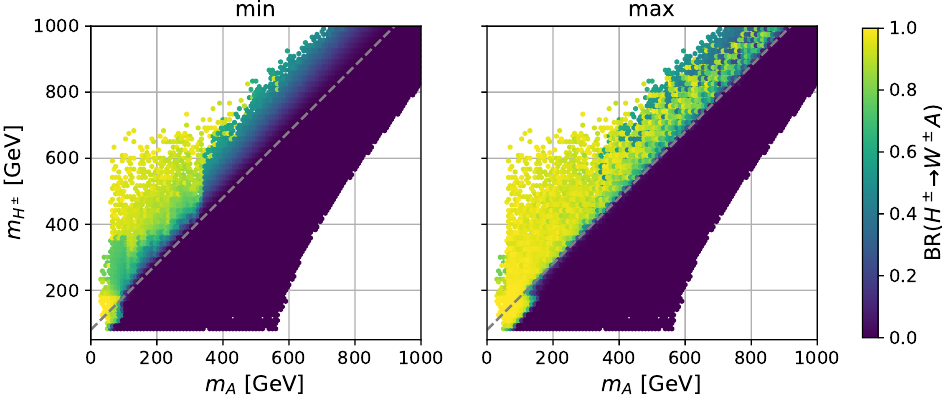
Figure 12. Branching ratio of the charged Higgs H ± into W ± A in the plane of the two Higgs masses. The left (right) plot shows the minimal (maximal) possible BR for each bin. The dashed line indicates where m = m + m . A W H ±